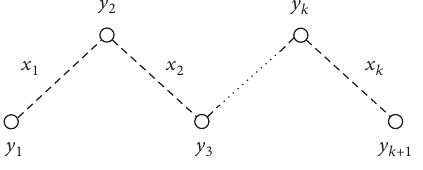
Figure 3: Illustration of a complex mixproduct: DP = X